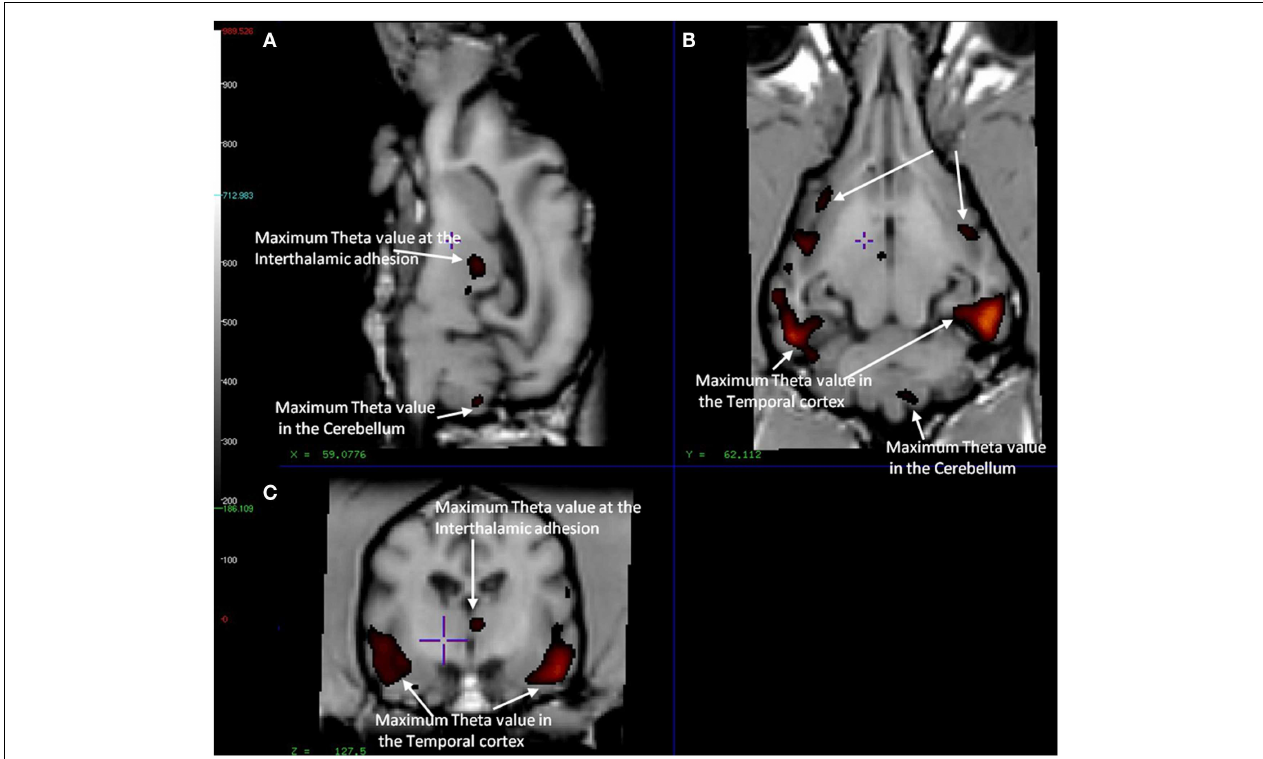
FIGURE 2 | Magnetic resonance imaging of the brain of CCD dogs with reference region of max average theta value (red/dark red) identical with an area of maximal washout characteristics of [11C]PiB highlighted in red and therefore minimum binding of [11C]PiB . (A) Mid-sagittal section of dog brain showing an area of max theta value (red/dark red) and therefore minimum [11C]PiB binding in the thalamic adhesion and the cerebellum.